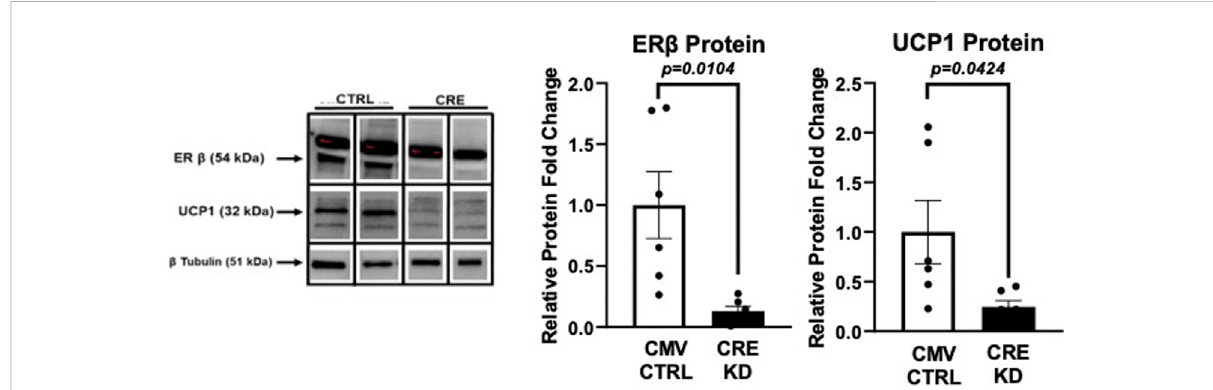
FIGURE 7 Ex vivo knockdown of ER β suppresses UCP1. Primary adipocytes isolated from PGAT and SQAT harvested from one male Esr2-loxP fl oxed mouse cre+/- weretransfected14daysafterinductionwith1.0×10 8 plaque-formingunits/mlmediarecombinantadenovirus(VectorBiolabs,Malvern, PA)containingCre-recombinase(CRE),oreGFP(CTRL),undertheCMVpromoter,for24 htodecreaseexpressionofER β , encodedbyesr2 .Western blottingwasperformedtoassessproteinexpressionlevelsofER β andthemitochondrial uncouplingprotein1(UCP1)relativetobetatubulin.All data are presented as mean ± SEM N = 6/group; p -value < 0.05 accepted as signi fi